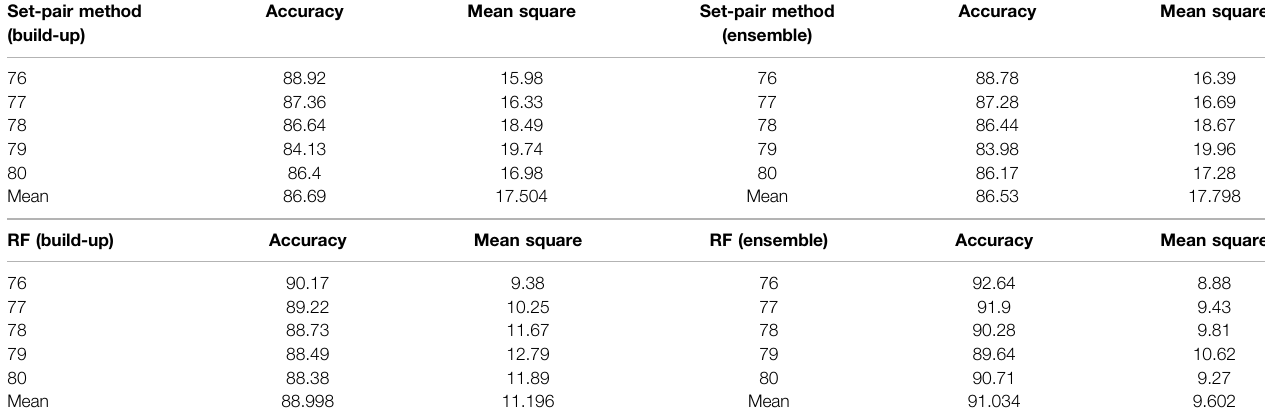
TABLE 1 | Comparison of prediction methods and strategies. Set-pair method